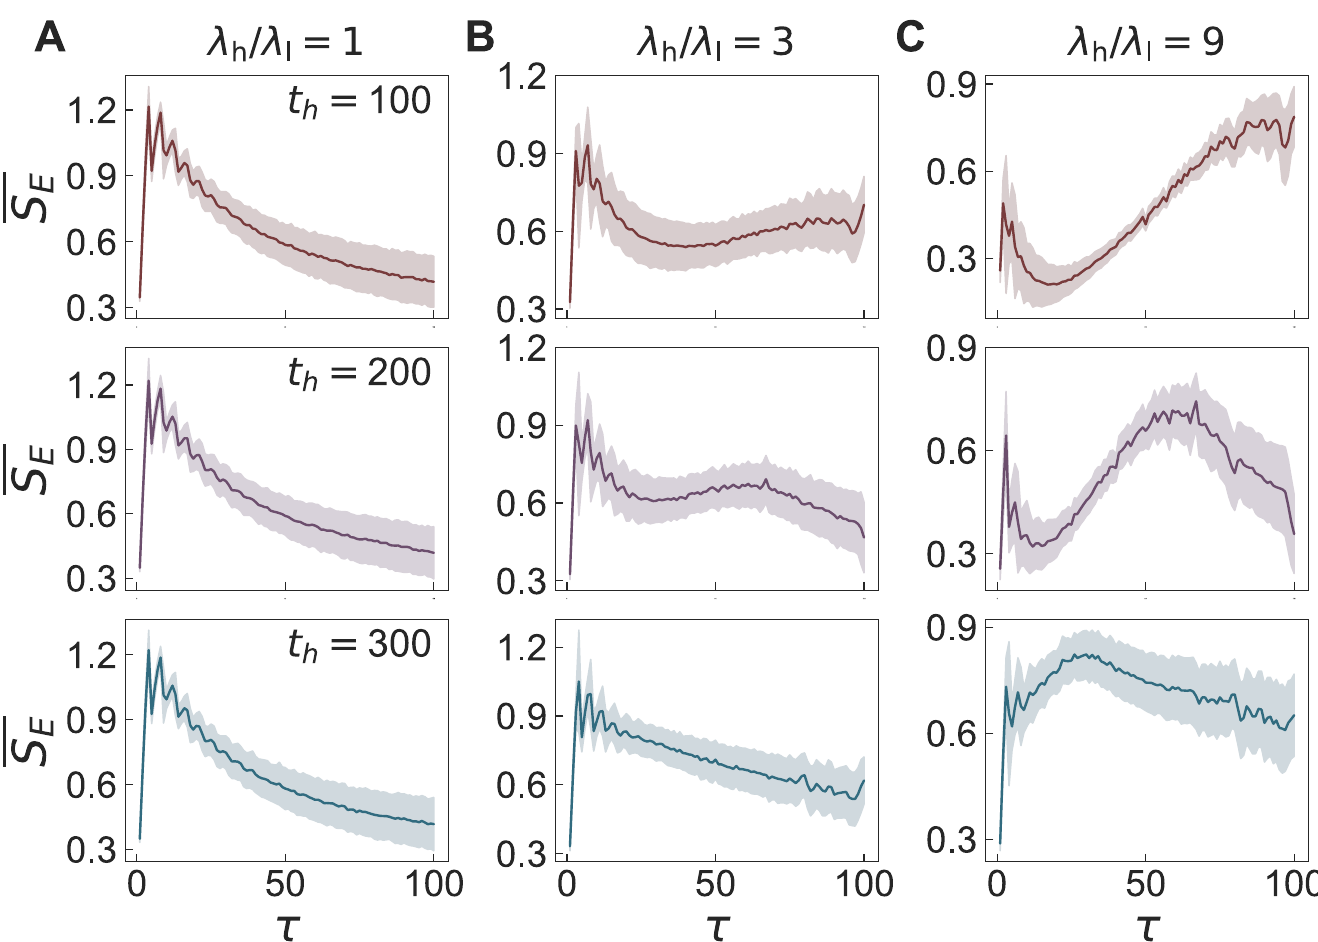
Fig 7. Results of the MSE method for the periodic time series model. Results of the MSE method applied to the time series { z ( t )} using the periodic time series model with Z = 1000, T = 2000, ρ = 0.2, and n = 5 for values of λ h / λ l = 1, 3, and 9 (left to right) and t h , 200, and 300 (top to bottom). For each panel, we have generated 10 3 time series to get the averaged curve S as a function of the scale factor τ E